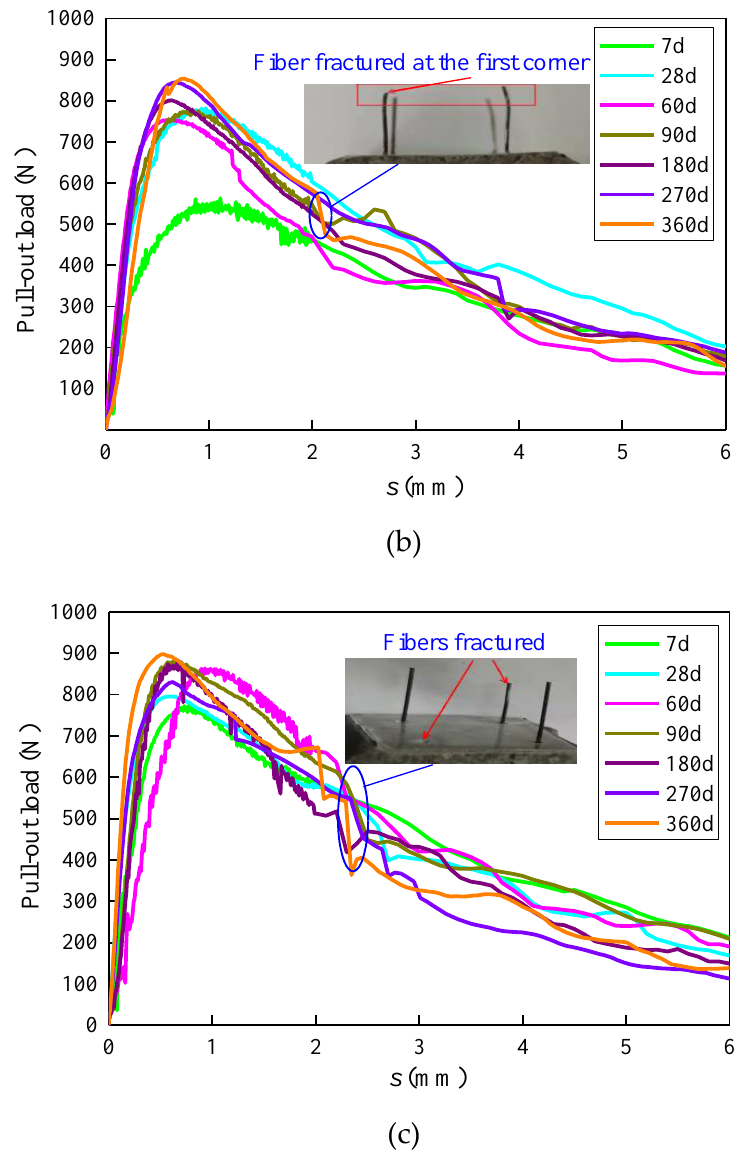
Figure 7. The characteristic PL-S curves at different curing ages. ( a ) M40 ( b ) M31 ( c ) M24. In the characteristic PL-S curves of M40, the pull-out load and slip varies continuously, corresponding to the failure of fibers pulled out with the whole-fiber hook ends being straightened. The descending portion of curves after 28 days have an obvious “step” shape. The pull-out load and slip of M31 varies continuously at 7 to 180 days with the steel fibers which were basically pulled out with straightened fiber ends. The pull-out load drops abruptly in the descending portion of the curves at 270 and 360 days, corresponding to the failure of one or two fibers fractured at the first corner of the hook-end. With continuous variation in the pull-out load and slip, the characteristic PL-S curves of M24 were basically pulled out with straightened fiber hook ends at 7 and 28 days. While the pull-out load drops abruptly in the descending portion after 60 days, corresponding to the fracture of one or two